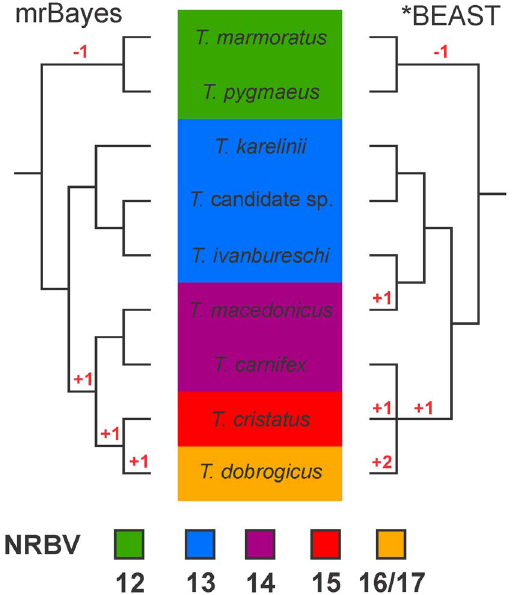
Figure 1. Previously argued phylogenetic hypotheses for the genus Triturus . Background colors reflect the variation in the number of rib-bearing pre-sacral vertebrae (NRBV) characterizing the five Triturus morphotypes. The two species with a green background are marbled newts and the remaining species are crested newts. The MrBayes phylogeny (left) is based on full mitochondrial genomes [19]. Posterior probabilities for all internal branches are 0.95 or higher. Note that this phylogeny is concordant with the most parsimonious interpretation of the evolution of the number of rib-bearing pre-sacral vertebrae (with the required character state changes noted in red). The *BEAST coalescent-based estimation of the species tree (right) is based on three nuclear introns (adapted from [20]). Posterior probabilities for internal branches are all below 0.95 and only those supported at over 0.75 are